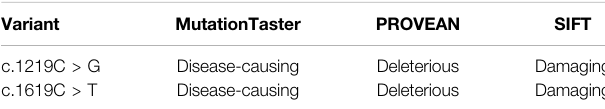
TABLE 1 | In silico analysis of the SMO variants c.1219C > G and c.1619C >